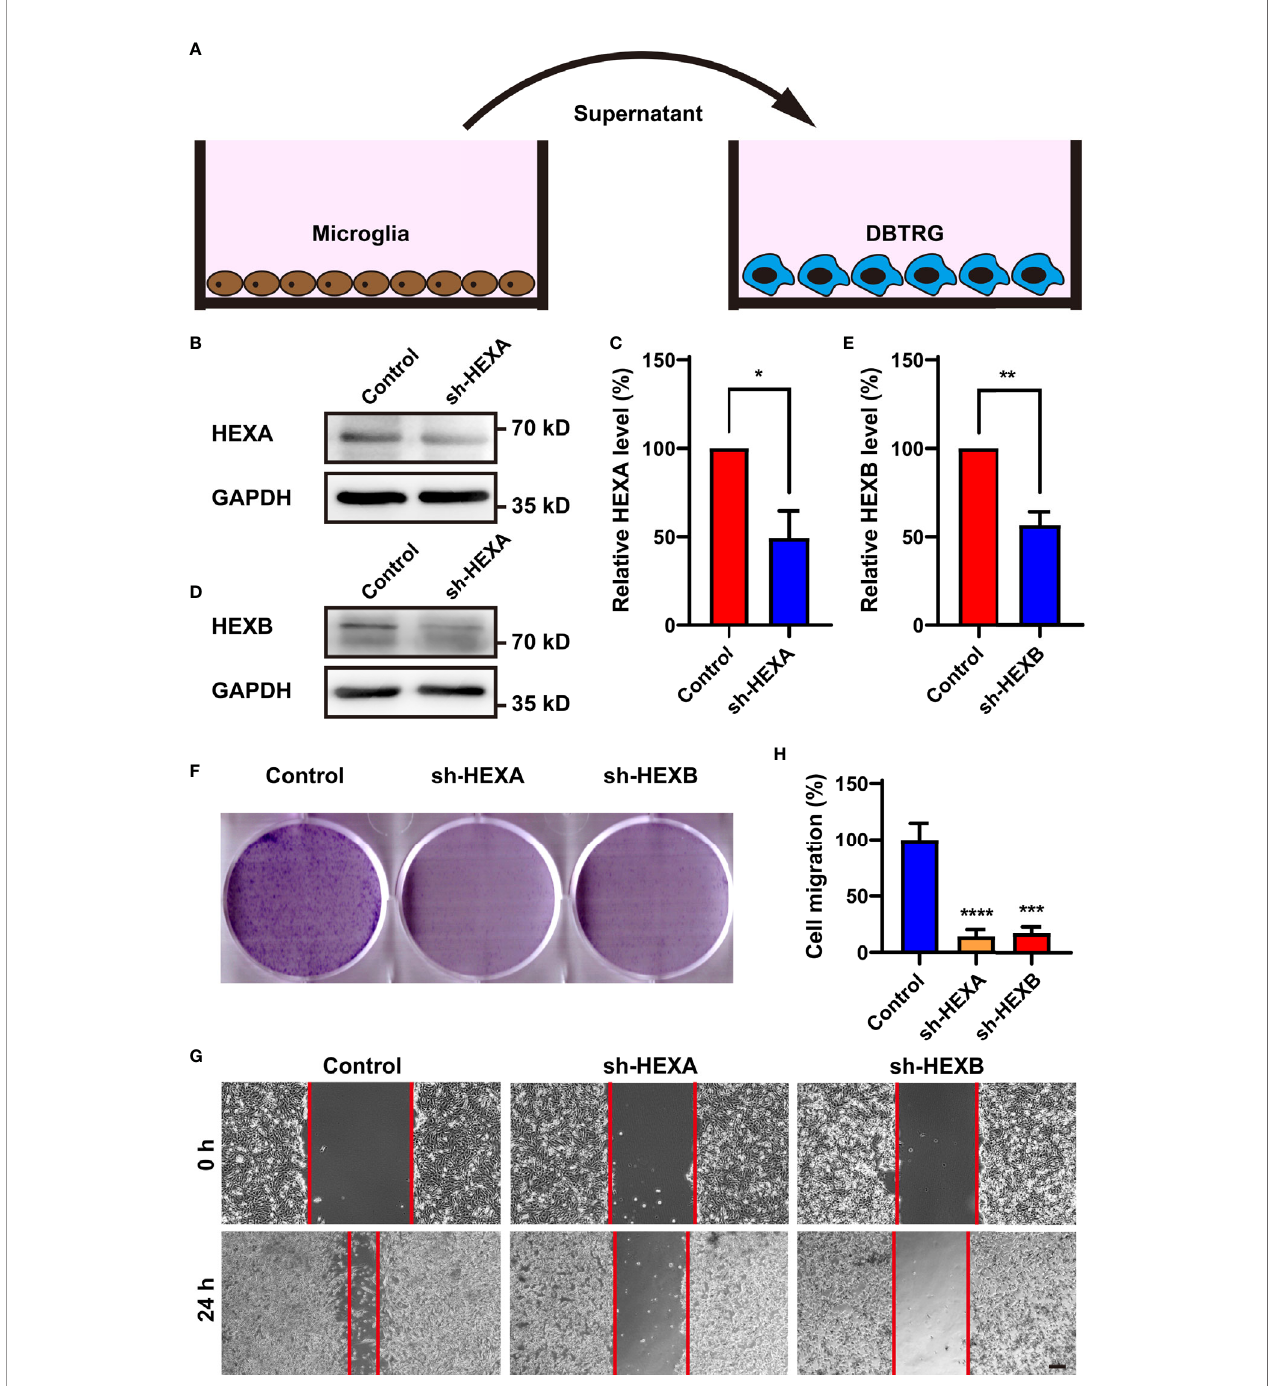
FIGURE 4 | Conditioned media from HEXA and HEXB-knockdown-microglia cells inhibited the proliferation and migration of DBTRG cells. (A) Schematic diagram of the in vitro experiments. (B) Western blot analysis of knockdown ef fi ciency of HEXA. (C) Quanti fi cation of HEXA expression as shown in (B) (n = 3) (t-test, sh-HEXA vs Control). (D) Western blot analysis of knockdown ef fi ciency of HEXB. (E) Quanti fi cation of HEXB expression as shown in (B) (n = 3) (t-test, sh-HEXB vs Control). (F) Representative images of DBTRG cells treated with conditioned media from control, HEXA and HEXB-sh-microglia cells in the colony formation assay. (G) Representative images of DBTRG cells treated with conditioned media from control, HEXA and HEXB-sh-microglia cells in the wound healing assay. (H) Quanti fi ed analysis of migration of DBTRG cells (n = 3) (one-way ANOVA, Control vs sh-HEXA and sh-HEXB). Scale bars = 100 m m. Data are presented as the mean ± SD. * p < 0.05, ** p < 0.01, *** p < 0.001, **** p <